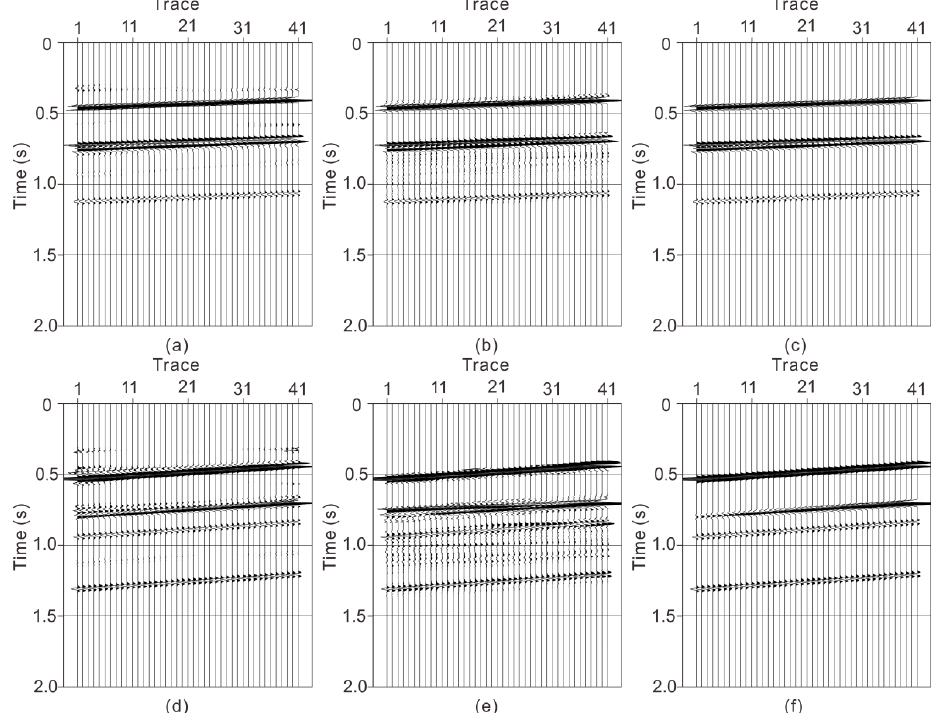
upgoing S-wave was obtained through Equation (10) and is shown in Figure 9d.